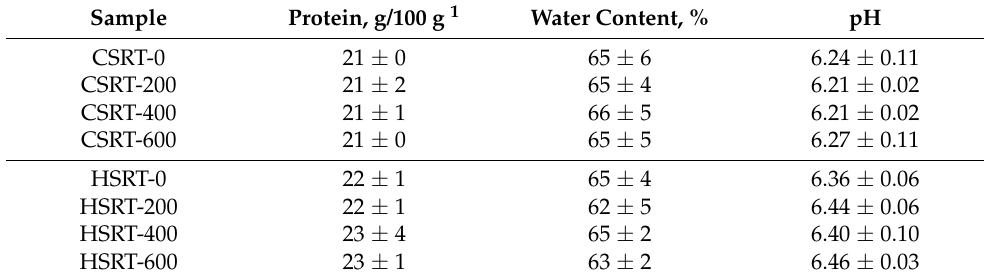
Table A2. Protein content (g/100 g ± standard deviation), water content (% ± standard deviation), and pH ( ± standard deviation) of cold smoked rainbow trout (CSRT) and hot smoked rainbow trout (HSRT) samples treated with high pressure processing at 0, 200, 400, and 600